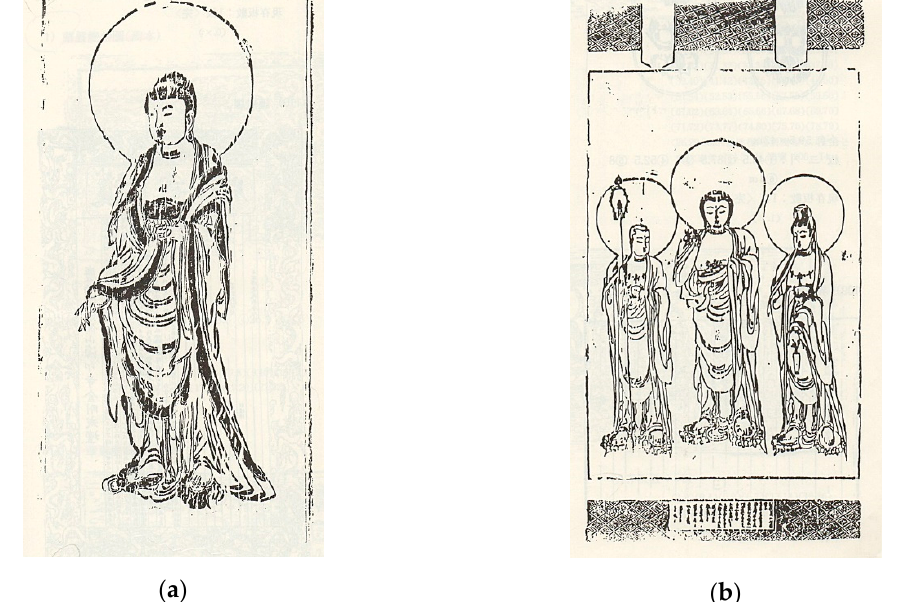
Figure 7. ( a ) Descent of Amitabha (K. Amitaba dokjon naeyeongdo ) and ( b ) Amitabha Triad (K. Amitaba samjondo ), presumed late Joseon—early Joseon, 50.0 × 33.0 cm, Haeinsa Temple. Source: (Park 1987, p. 365).